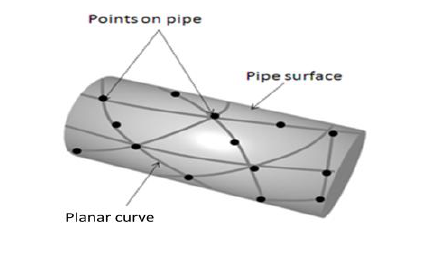
Figure 1. Surface representation using planar curves. The curves share common points even though they run in different direction.